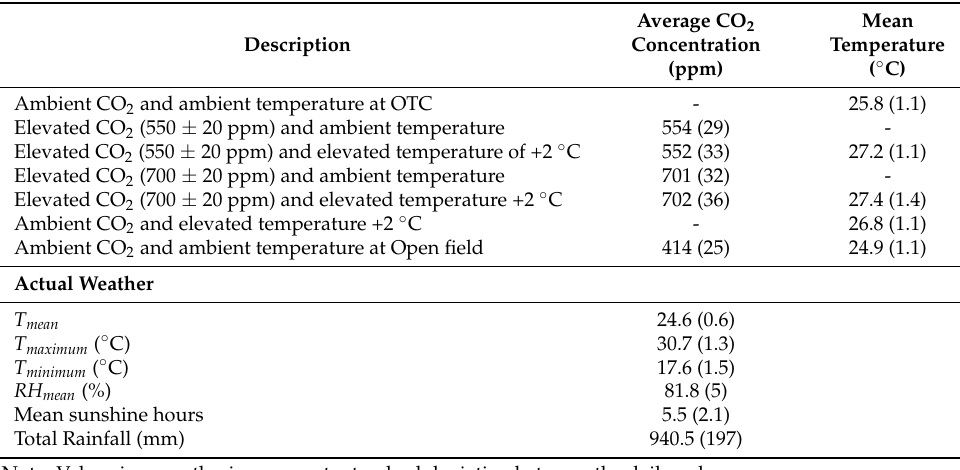
Table 2. Average CO 2 , Temperature values recorded under each of the OTCs and the actual weather conditions prevailed during the